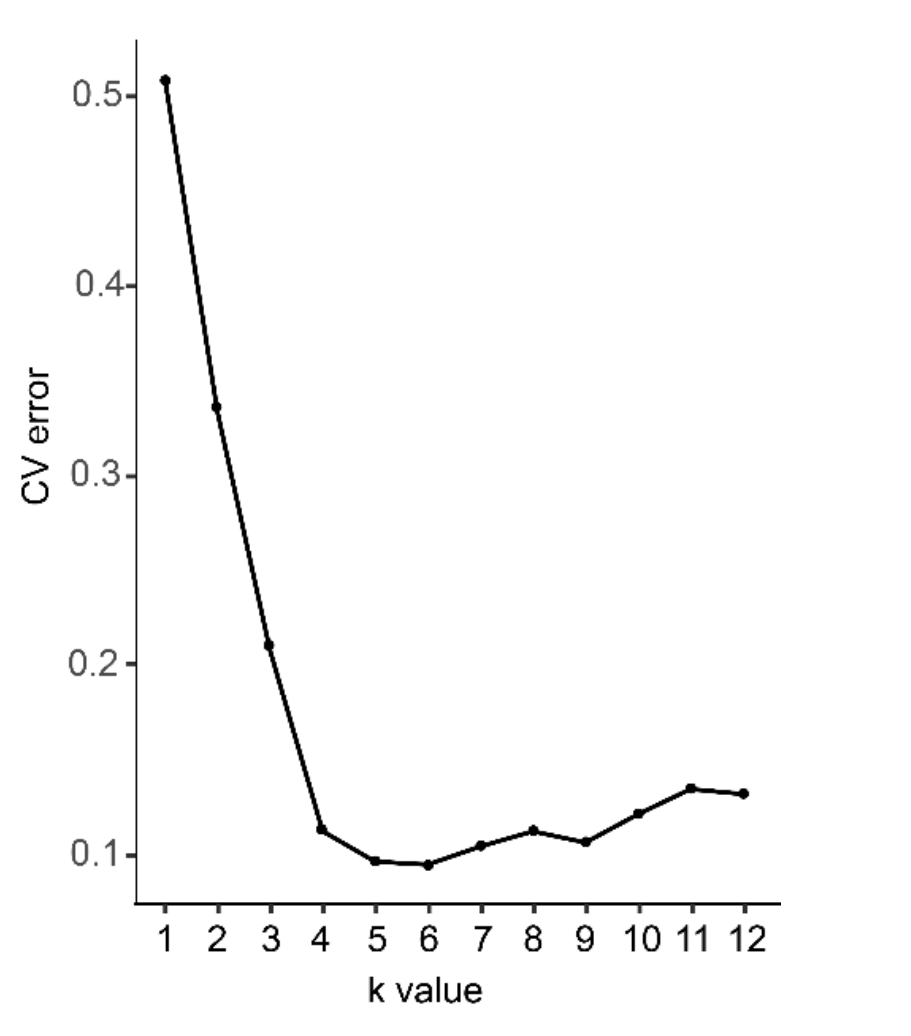
Figure 1. The probability of best fit into each number of assumed clusters (K).